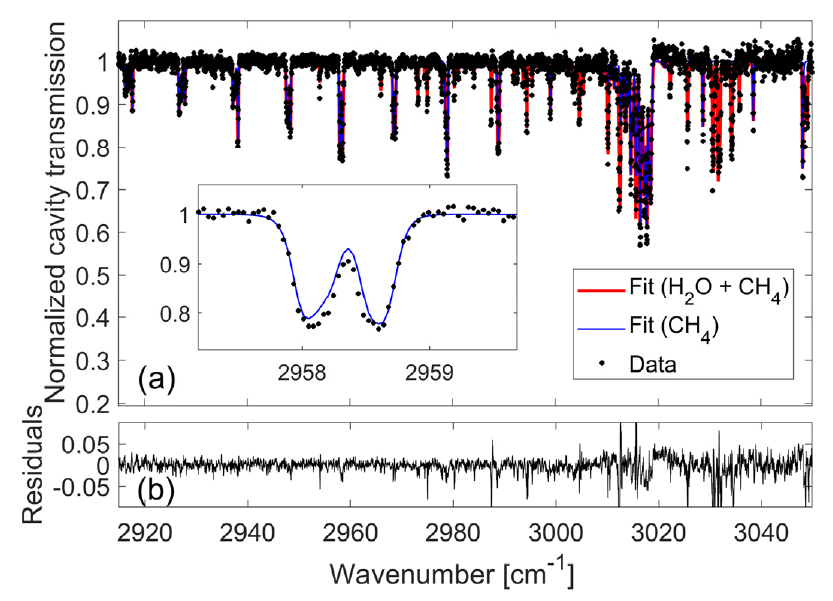
Figure 6. ( a ) Normalized spectrum (single scan) of methane and water (black markers) together with a fit of the model (red—both species, blue—only methane) and ( b ) fit residuals.